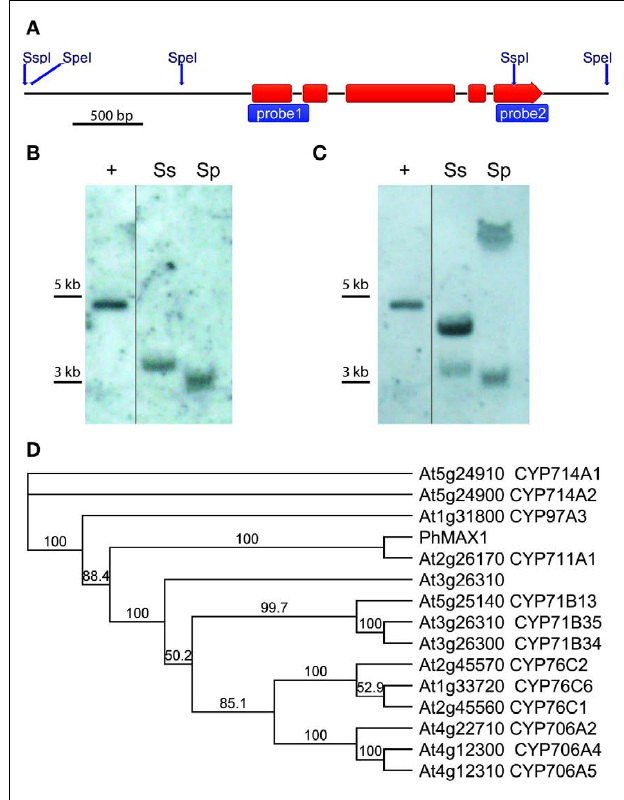
FIGURE 2 |The PhMAX1 gene. (A) Structure of the gene, exons are shown in red, probes and restriction enzymes used in the Southern analysis are shown in blue. (B,C) A petunia genomic DNA Southern blot probed with a fragment of PhMAX1 with either (B) high, probe 1, or (C) low, probe 2, variability amongst cytochrome P450 genes.The image shown in (B) is from a high stringency wash (0.1 × SSC, 65˚C), a prior medium stringency wash (0.5 × SSC, 65˚C) showed no additional bands.The image in (C) is from a medium stringency wash.The lanes are: + , positive control; Ss, Ssp I digest; Sp, Spe I digest.The line indicates where intervening lanes have been removed for clarity. (D) A maximum likelihood phylogeny showing the petunia MAX1 protein in relation to similar CYP450 proteins in Arabidopsis . Sequences have been labeled with theirTAIR locus number and any CYP450 name associated with the sequence. CYP711A1 is MAX1.The tree is unrooted and the values indicated on branches are bootstrap percentages (out of 1000